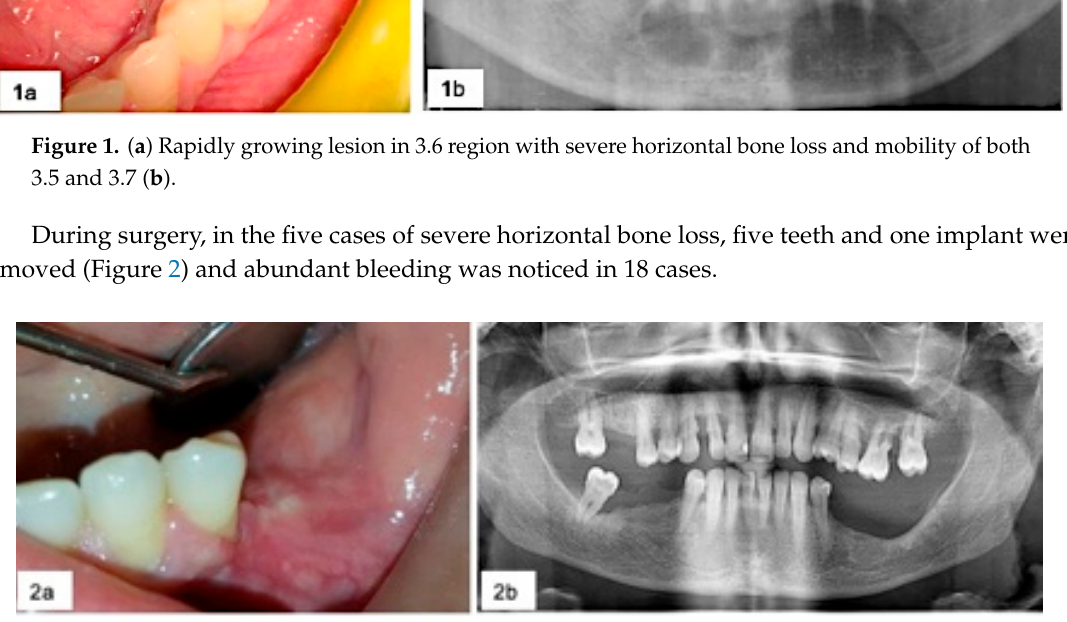
Figure 3. Histological aspects of peripheral giant cell granulomas (PGCG) with giant cells and stromal new formed osteoid bone. ( a ) Panoramic view of PGCG with ulcerated covering mucosa in the upper right region; ( b ) Thin trabecular osteoid bone with surrounding cellular stroma with spindle-shaped fibroblast-like cells ( c ) 40× magnification showing giant cells with variable number of nuclei and different shapes ( d ) Panoramic view with many giant cells surrounded by stroma. In all the patients enrolled in this study, haematological investigation demonstrated elevated values of parathyroid hormone and serum calcium ruling out an unknown primary HPT. Specifically, after endocrinological evaluation, non-invasive radiological assessment of parathyroid glands and eco-guided FNAC, 13 patients showed HPT related to parathyroid adenoma, 2 related to parathyroid hyperplasia (one of which occurred in a intra-thyroidal parathyroid—Figure 4), and 1 related to parathyroid carcinoma and were scheduled for surgical treatment. No recurrence was noticed except for two patients with PHPT, one female with parathyroid hyperplasia that refused surgical treatment and one male with adenoma with delaying in surgical treatment.